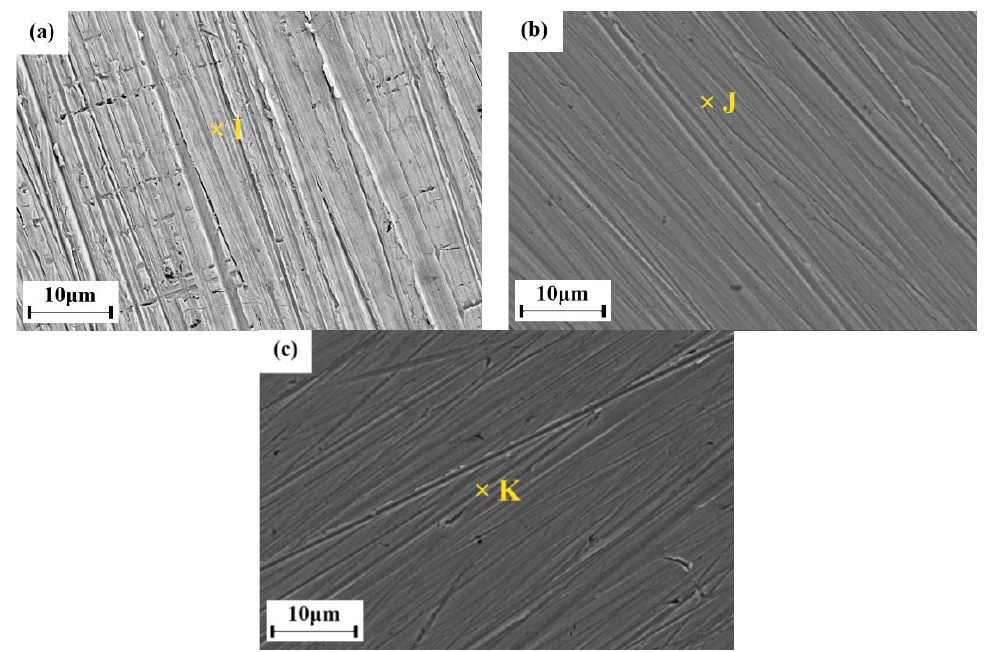
Figure 9. Surface morphology of 304 SS with polarization at − 0.50 V for 20 h ( a ), 70 h ( b ) and 168 h ( c ).